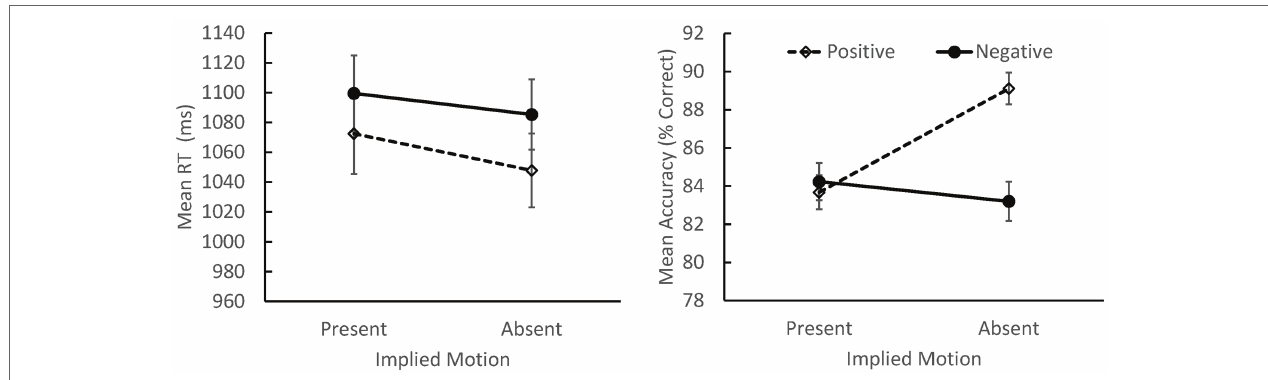
FIGURE 1 | Mean response times (RTs; left panel ) and accuracy (right panel) for judgments of positively and negatively valenced scenes that did or did not depict IM (SEs indicated). Overall, participants responded more quickly to positive than negative images, and to images that did not depict IM. Accuracy was highest when classifying positive scenes without